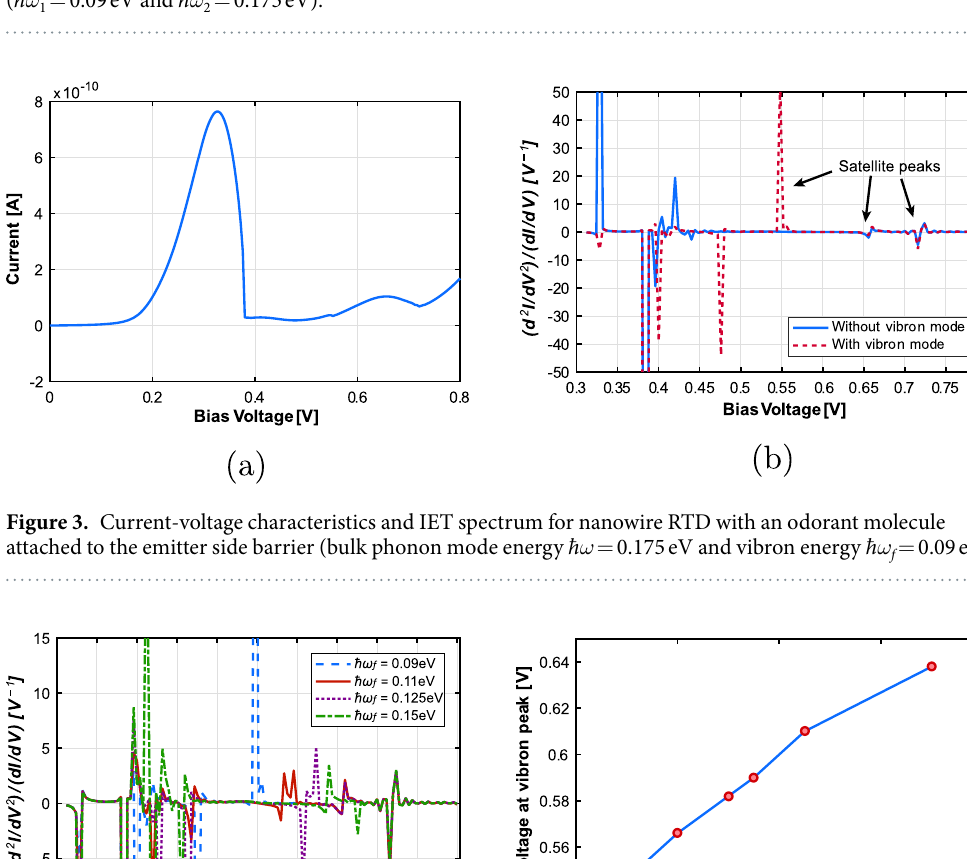
Figure 2. Current-voltage characteristics and IET spectrum for nanowire RTD with two bulk phonon modes ( ħ ω 1 = 0.09 eV and ħ ω 2 = 0.175 eV).